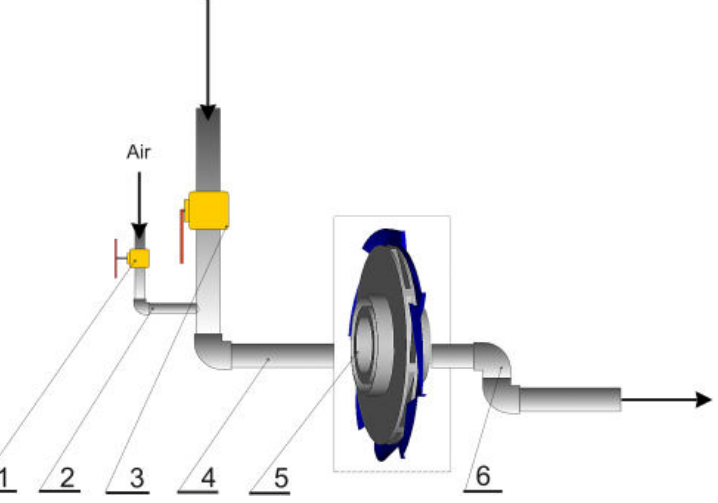
Figure 9. Scheme of supplying air during the visualization tests: 1—air quantity control valve; 2—air supplying pipe; 3—shut-off valve; 4—suction pipe; 5—model pump; 6—discharge